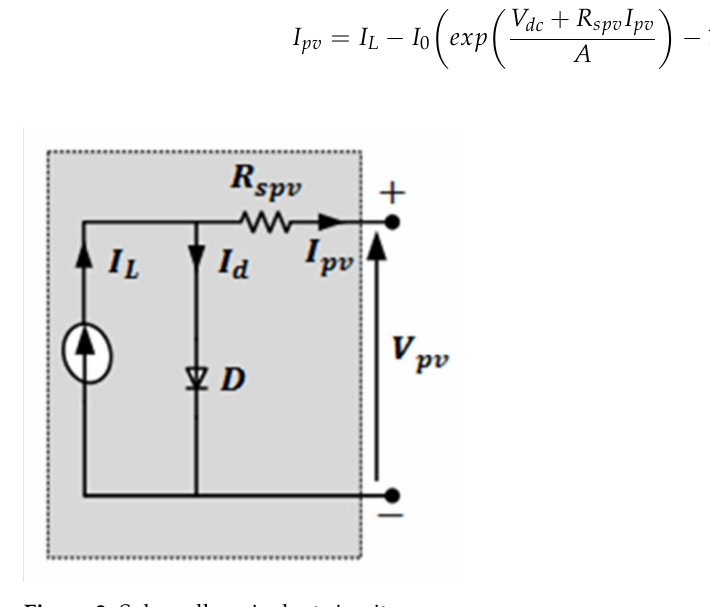
Figure 2. Solar cell equivalent